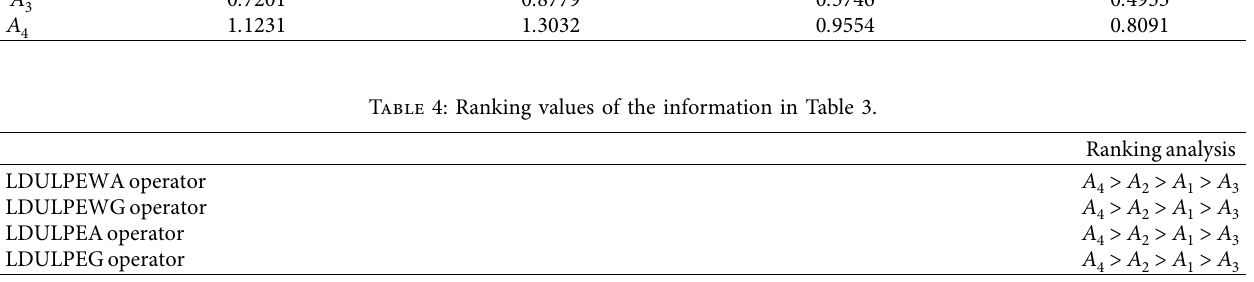
Table 4: Ranking values of the information in Table 3.